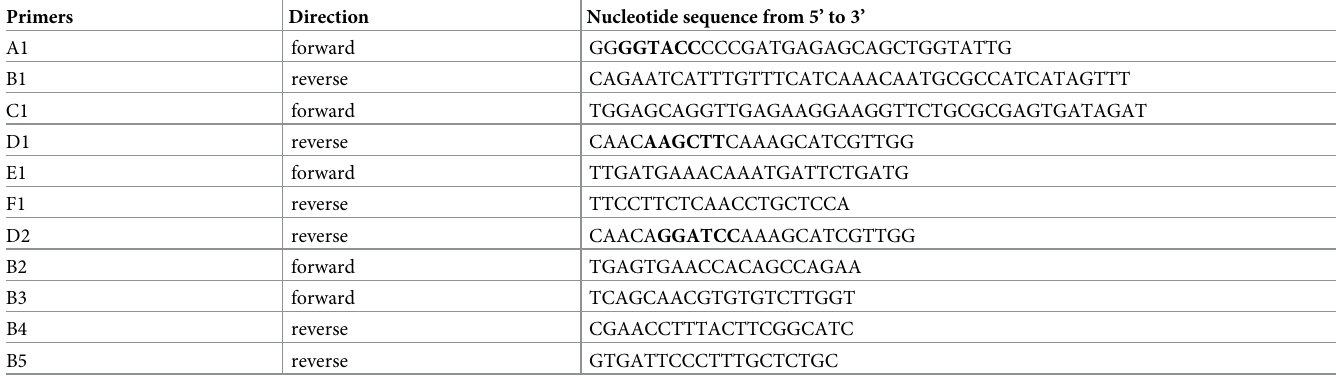
Table 1. Oligonucleotide